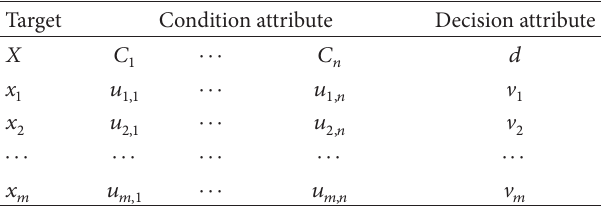
Table 1: Decision table general